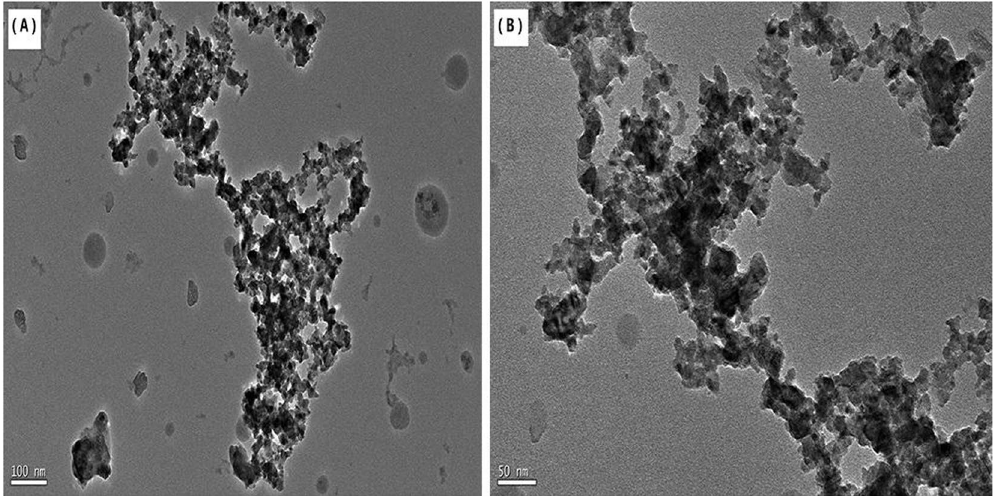
Figure 3. The TEM images of the